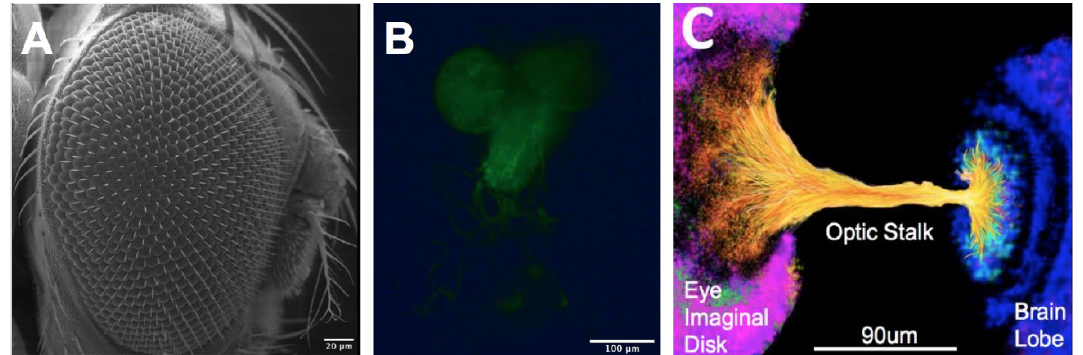
Figure 1. The Drosophila Melanogaster model of the developing visual system. ( A ) SEM image of the visual system of an adult fruit fly. ( B ) Representative eye–brain complex extracted from the third instar larval stage of development illustrating green fluorescent protein (GFP) + cells of glial lineage. ( C ) Rendering of the developing optic stalk connecting the brain lobe and eye imaginal disk. Colors represent eye imaginal disc (pink), neuroblasts (yellow / orange), and brain lobe (blue).